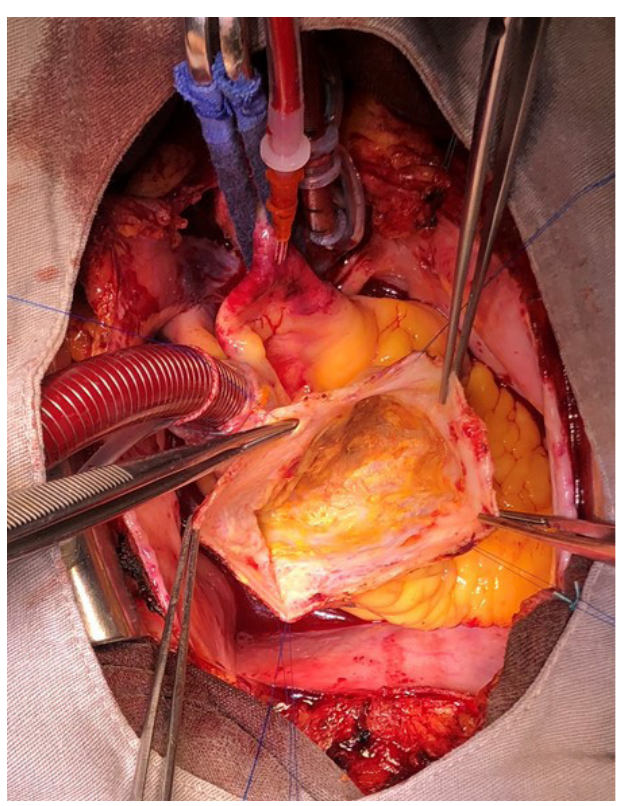
Fig. 2 - Intraoperative view of aneurysm exclusion.